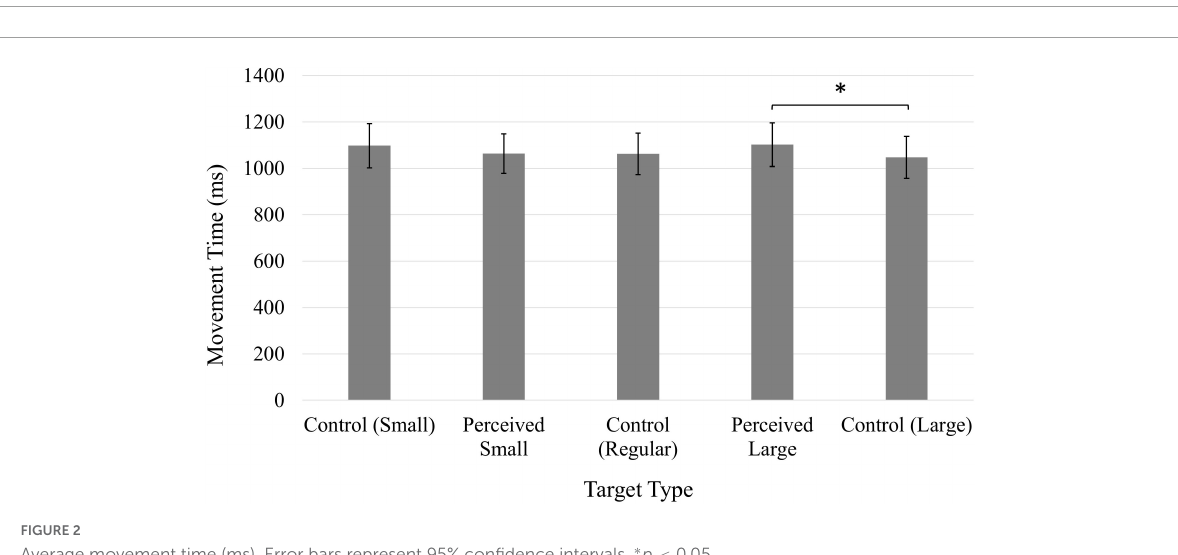
significant main effect of Position, F (1, 49) = 8.54, p < 0.01), η 2 = p